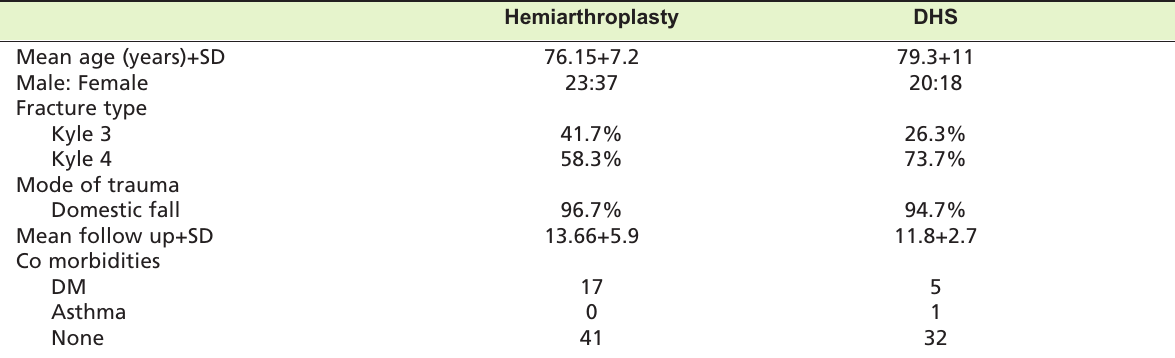
Main demographic and clinical data Table I: